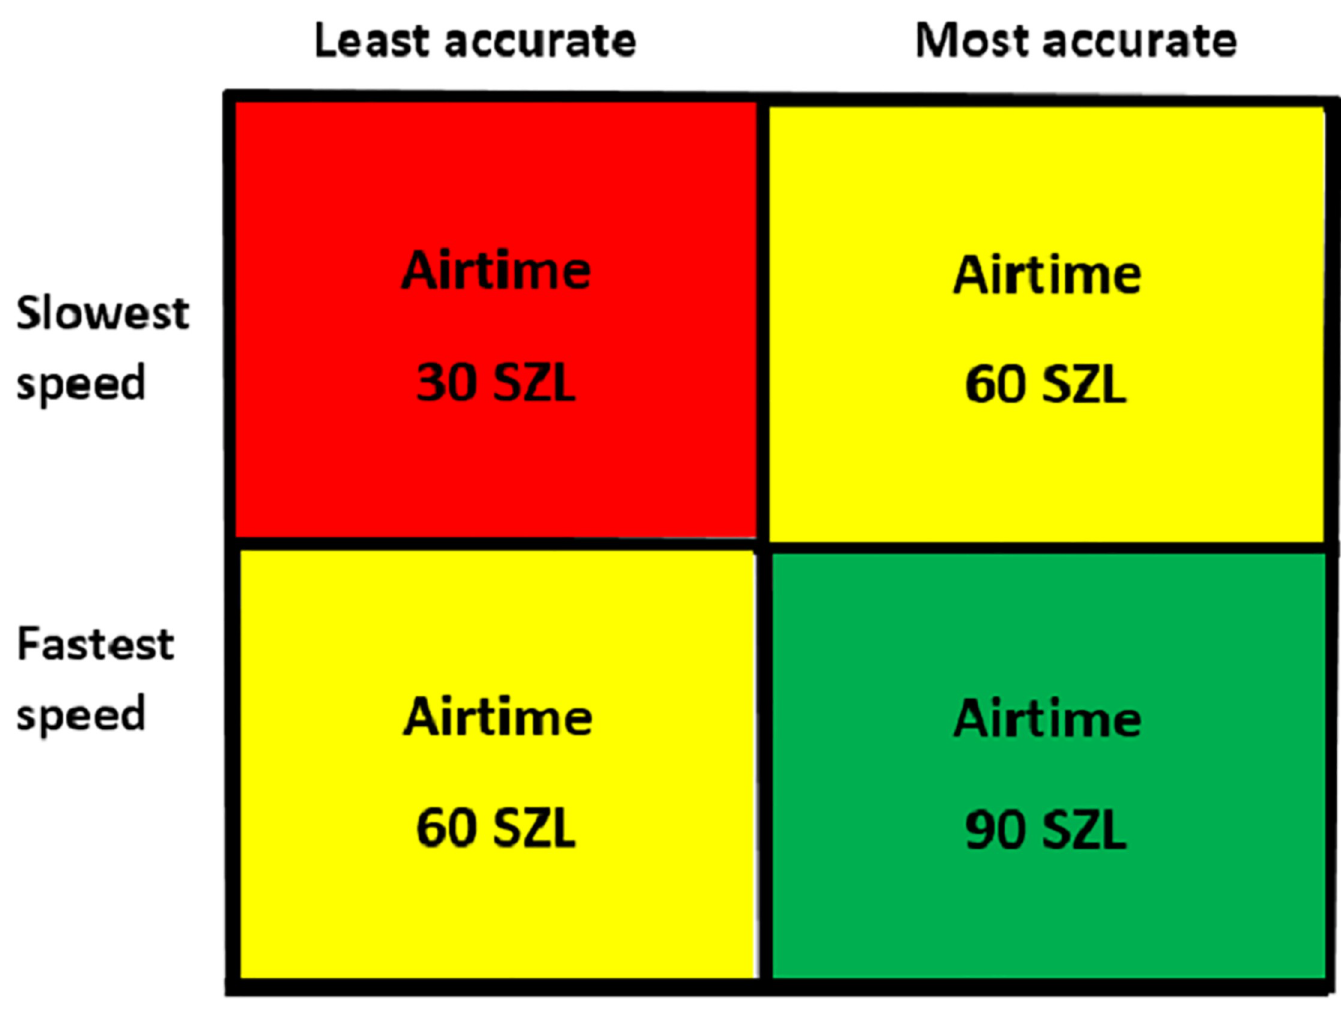
Fig 1. Payout table for SAFEcount